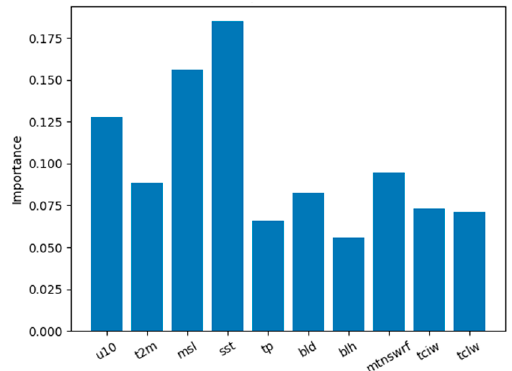
Figure 8. Feature importance of candidate meteorological factors.